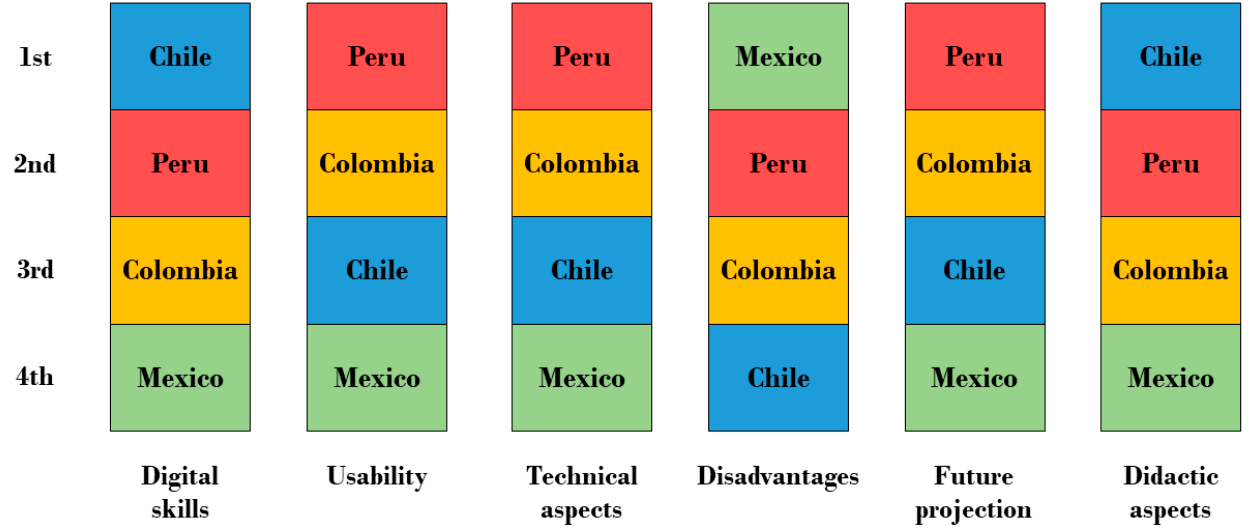
Figure 5. Ranking of the PA countries according to the average scores given in each of the families of questions in the questionnaire.